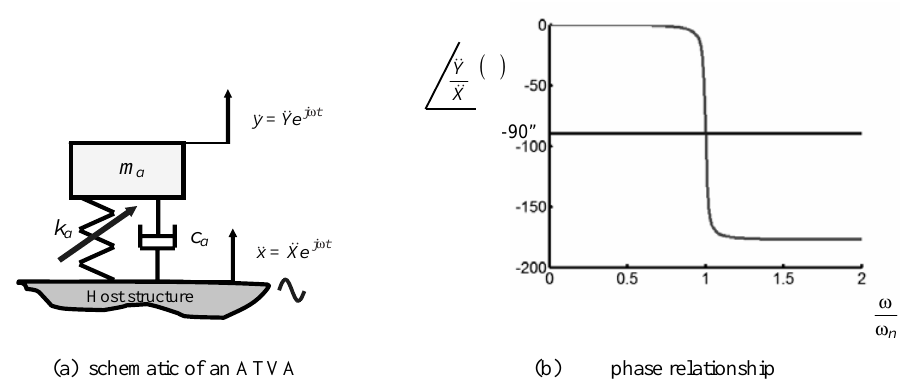
Fig. 15. Schematic of an ATVA on a structure and the phase relationship between the acceleration of the host structure and the ATVA mass. ATVA an experiment was setup as shown in Fig. 13(b). The accelerance (resulting acceleration/applied force) of the ATVA was measured using PCB impedance head type D288 D01 over a range of frequencies. A trough in the measured accelerance denotes the natural frequency of the ATVA (as opposed to the peak in the impedance in the previous section). To determine the natural frequency of the device with no magnetic field applied the permanent magnets were replaced by brass pieces of the same mass. The experimental results are shown in Fig. 14. It can